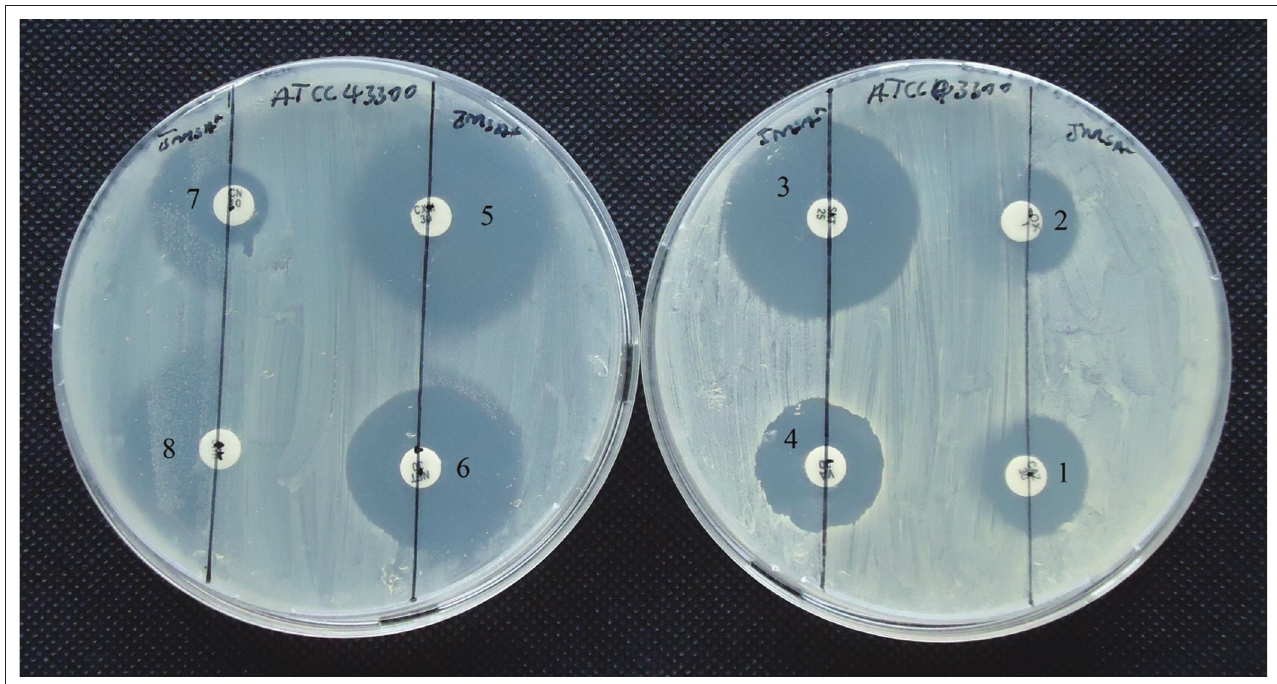
FIGURE 2: Antibiogram test of S. aureus isolate. The isolate was resistant to: ceftazidime, 30 µ g (1); oxacillin, 1 µ g (2); vancomycin, 30 µ g (4); netilmicin, 30 µ g (6); gentamicin, 10 µ g (7); erythromycin, 15 µ g (8); and cefuroxime, 30 µ g (5). However, it was sensitive to trimethroprim-sulfamethoxazole, 25 µ g (3).